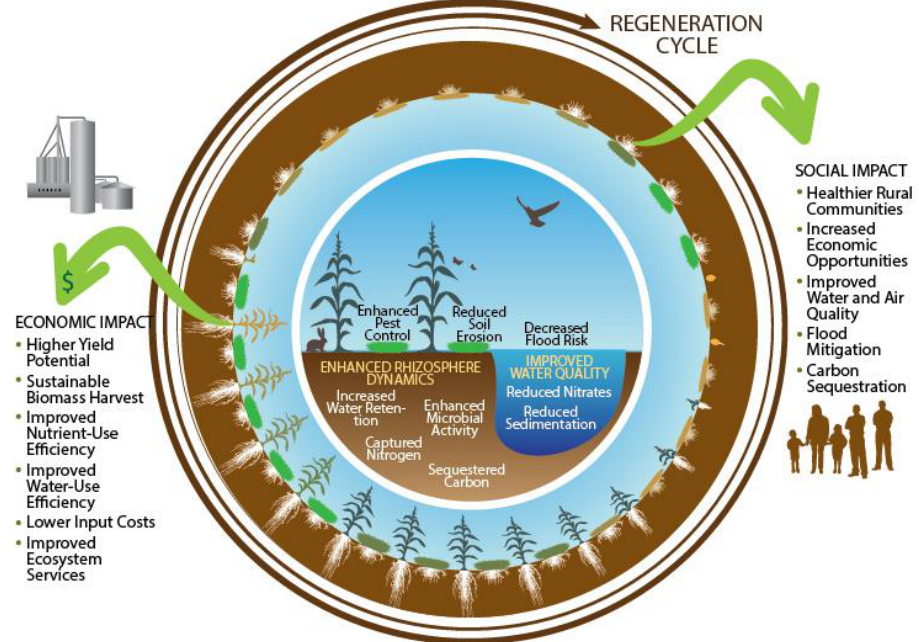
Figure 9. Illustration of interplay between perennial cover and annual crop over a growing year for the proposed system (mid-winter is up). Key events are illustrated clockwise from top, including spring planting of primary crop coinciding with induced die-back of perennial crop, early growth of primary crop while perennial is dormant, resurgence of groundcover as primary crop matures, and continued presence of groundcover post-harvest. Each complete cycle further regenerates soil health and ecosystem stability. The economic and social impacts represent goals to be achieved and have yet to be verified by research.